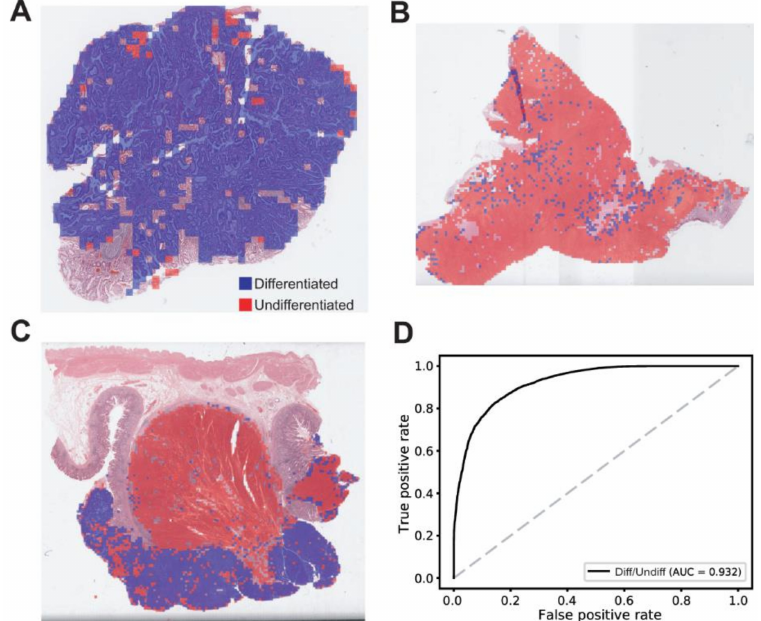
Figure 2. Results for the differentiated/undifferentiated classification on the TCGA-STAD dataset. ( A ) A representative heatmap overlaid on a tissue slide image demonstrating a mainly differentiated tumor tissue. ( B ) A representative heatmap overlaid on a tissue slide image demonstrating a mainly undifferentiated tumor tissue. ( C ) A representative heatmap overlaid on a tissue slide image demonstrating a mixed tumor tissue. ( D ) The patch-level area under the curve (AUC) for the receiver operating characteristic curve of the differentiated/undifferentiated classifier.